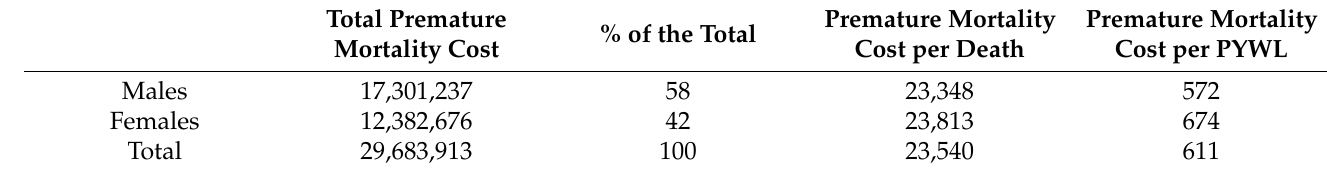
Table 2. Premature mortality cost by sex per death and per Potential Years of Work Lost (PYWL) (USD 2017). Total Premature Mortality Cost